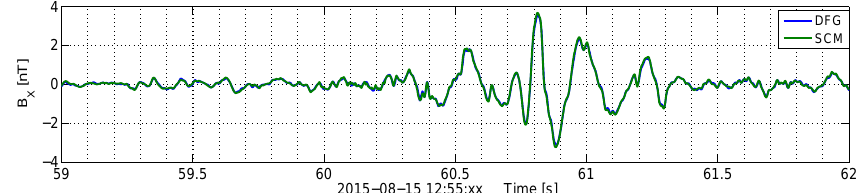
Figure 11. Comparison of MMS 3 frequency compensated data of DFG and SCM in time domain with band limitation from 4 to 64Hz.